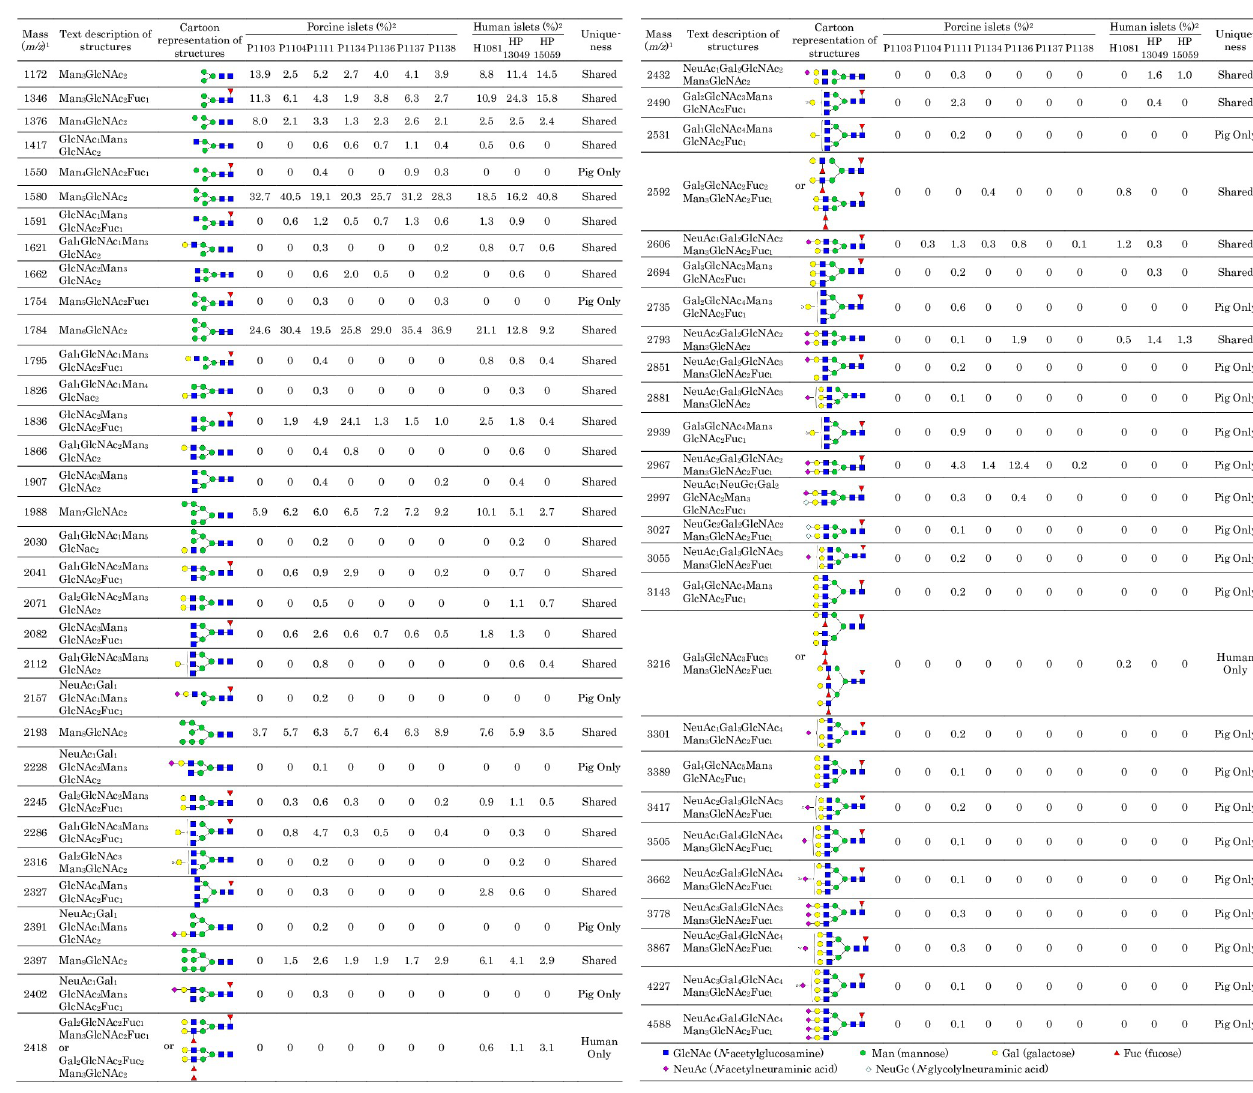
PLOS ONE | https://doi.org/10.1371/journal.pone.0241249 November10,